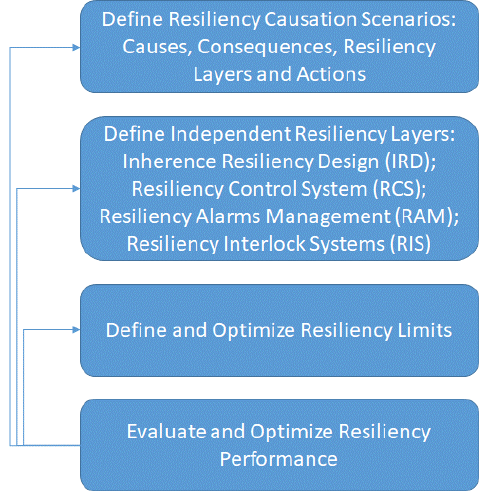
Figure 7. Proposed resiliency design framework.